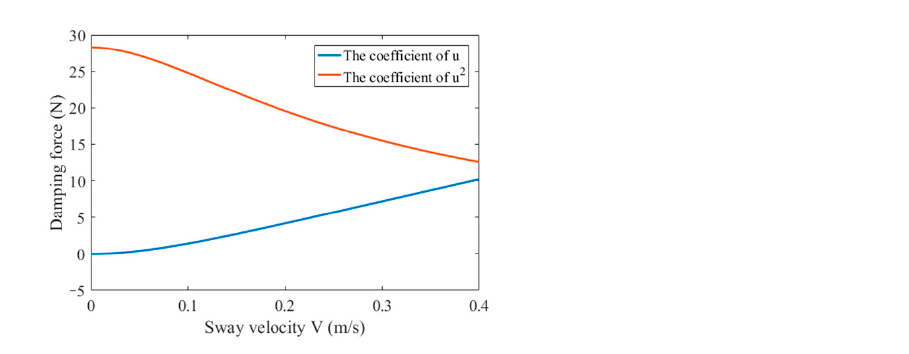
Figure 7. The curve of damping force in surge direction changing with disturbance velocity (sway velocity) under different surge velocities.